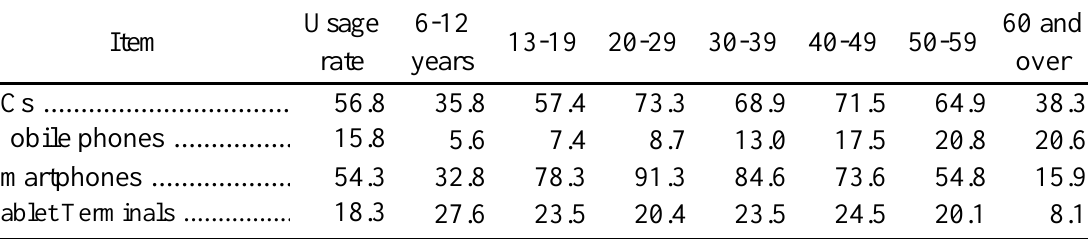
Source: Ministry of Internal Affairs and